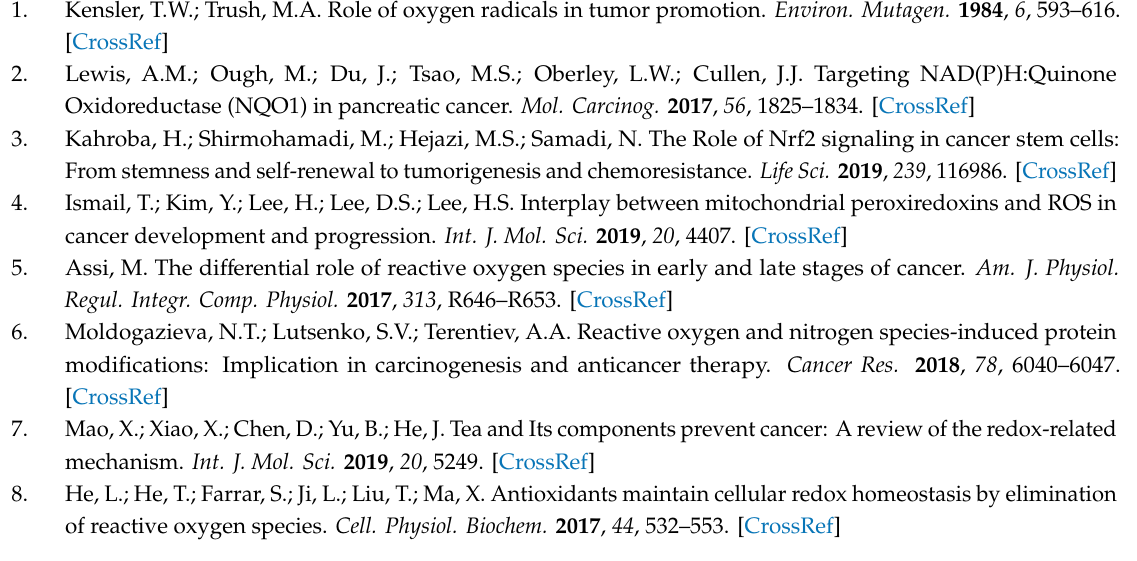
Table S1: Cytotoxic activity of all acylselenourea derivatives synthesized. Figures S1–S17: Supplementary data for DPPH assays. Figures S18–S26: Supplementary data for ABTS assays. Figure S27: General structure used to assign the chemical shifts in NMR spectroscopy. Figures S28–S168: NMR spectra ( 1 H, 13 C and 77 Se) of final products. Author Contributions: Conceptualization and funding acquisition, C.S. and D.P.; synthesis and biological evaluation, A.C.R., S.R.-I., I.T., and C.A.; supervision of the cytotoxic evaluation, I.E.; writing (original